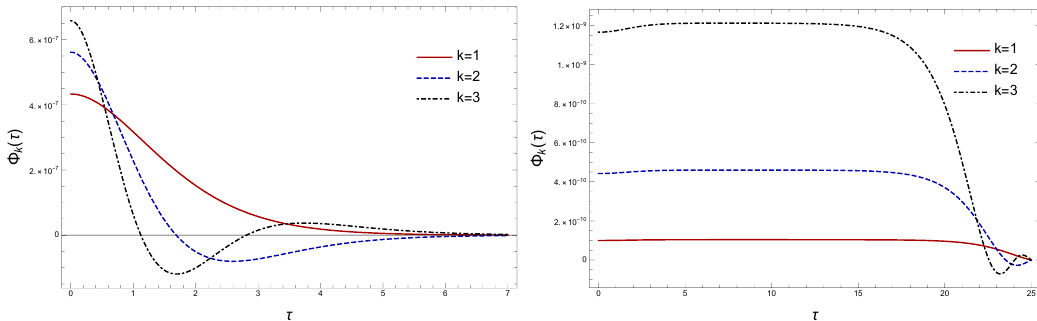
Figure 7 . Wavefunctions obtained analytically in the limits τ c → T (3.48) and τ c → 0 , with T = 25 . Notice the localisation near the tip in the limit τ c → T and the spreading of the wavefunctions in the limit τ c → 0